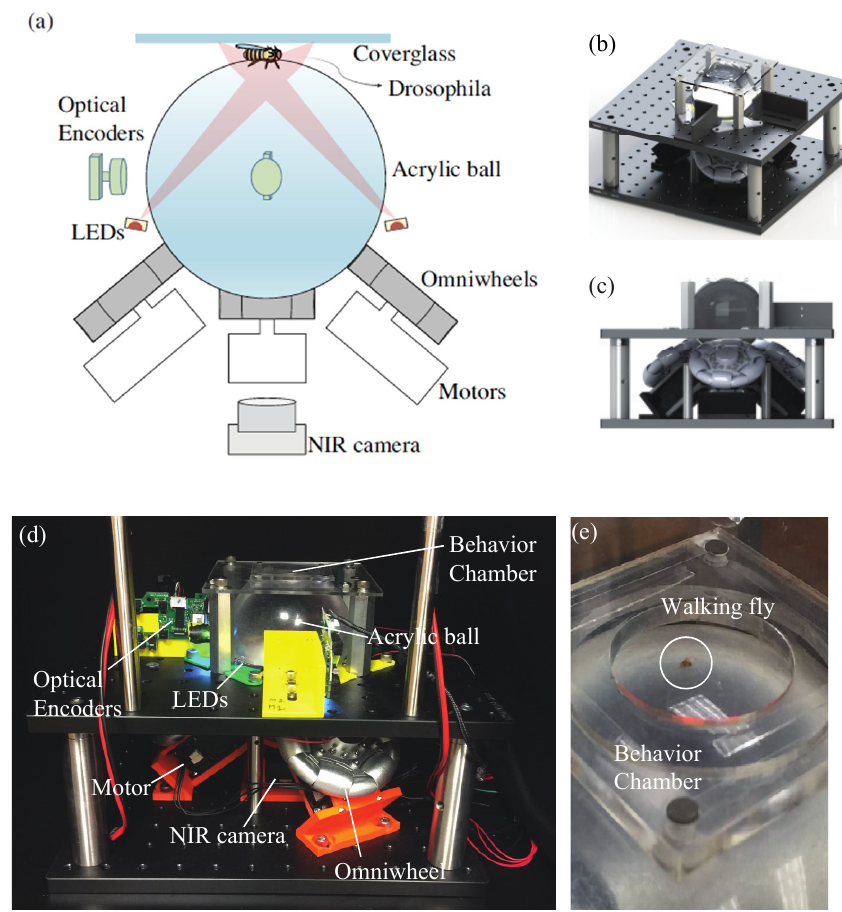
Figure 1. ( a ) Schematic drawing of the Transparent Omnidirectional Locomotion Compensator (TOLC) for a freely walking fruit fly ( b , c ) Design of Experimental set-up ( b ) isotropic view ( c ) front view ( d ) A real picture of the developed experiment device, the overall size is approximately 304.8 × 304.8 × 207 mm (width × depth × height) ( e ) A walking fruit fly on the real experimental set-up (see Video